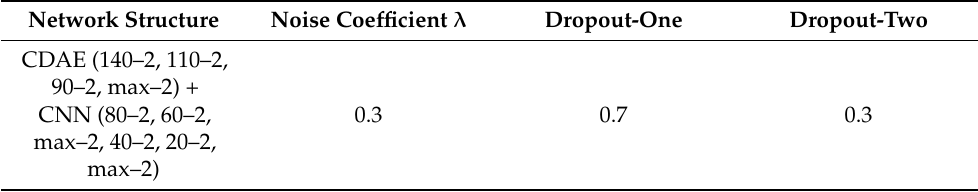
Table 3. CDAE-CNN optimal parameter.